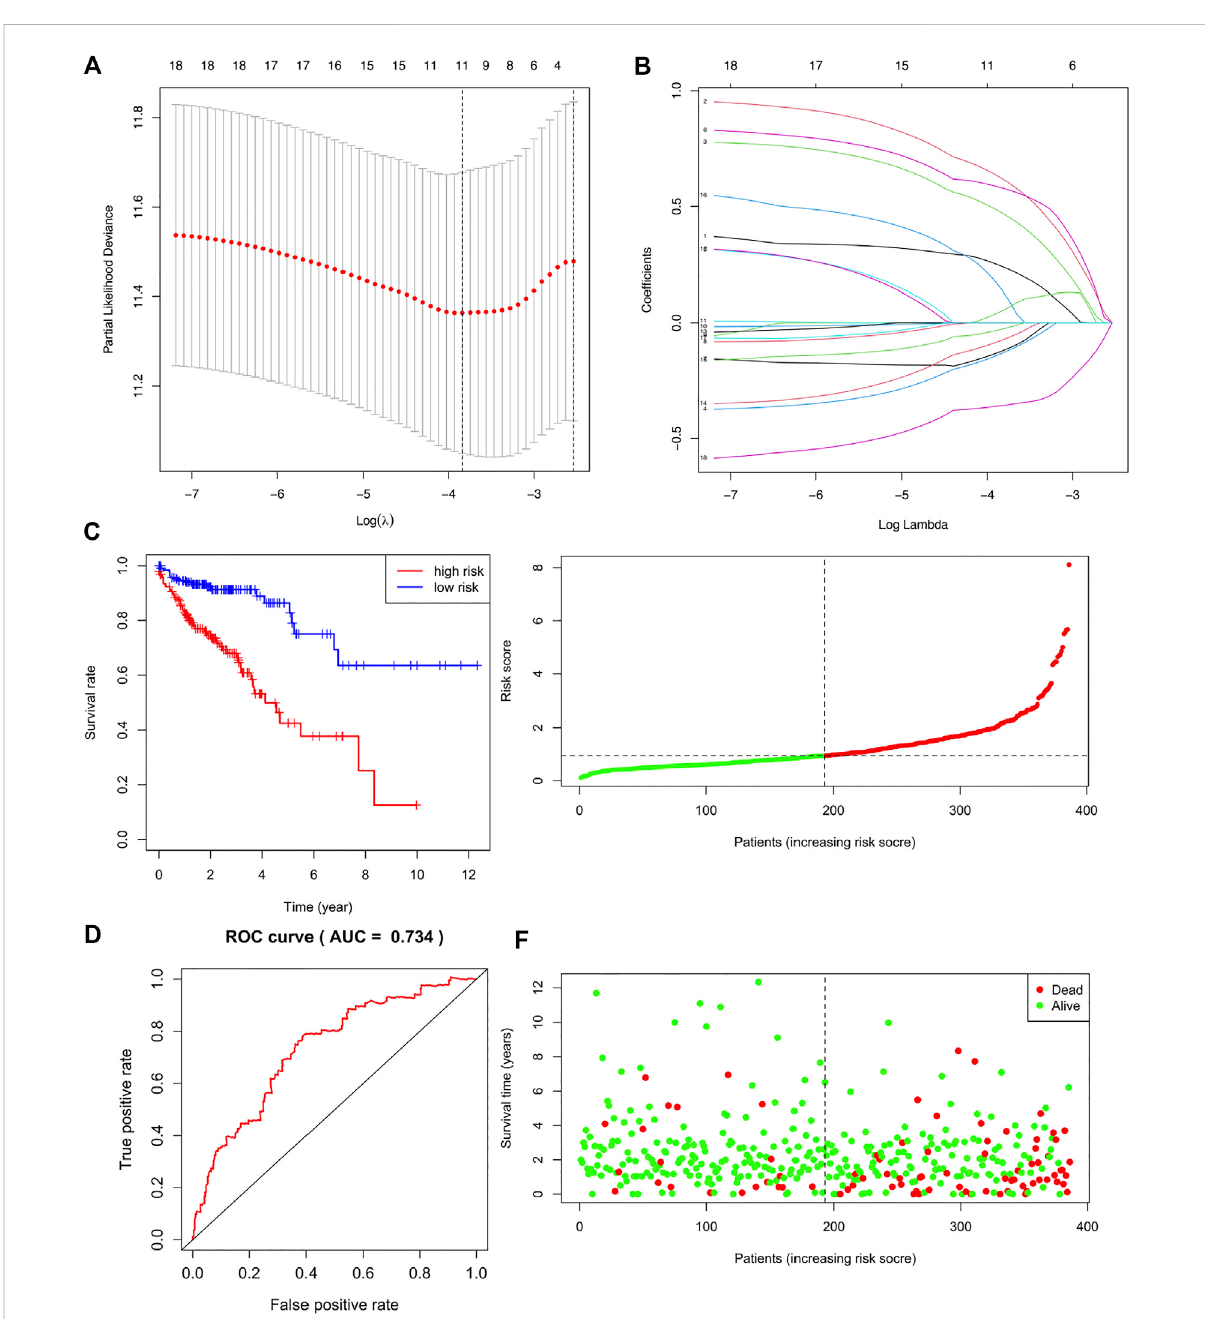
FIGURE 1 Construction and Validation of a fatty acid metabolism-related gene signature in COAD. (A,B) The LASSO coef fi cient pro fi les of the 18 FAM- related genes signature. (C) Kaplan-Meier (KM) analysis of OS based on the 8 FAM-related signature. (D) ROC analysis of the risk signature in predicting the OS. (E) Survival status distribution in high-risk group and low-risk group. (F) Risk score distribution of the high-risk group and low-risk